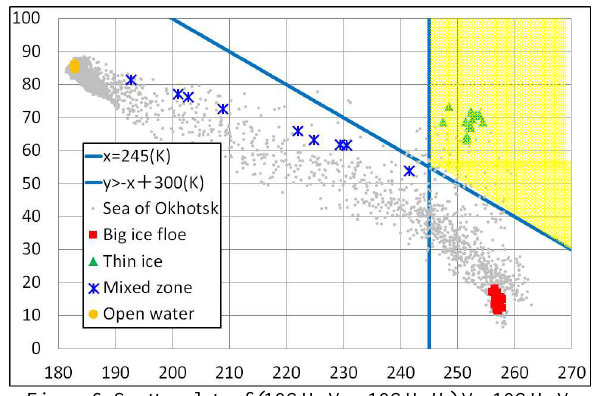
Figure 6. Scatter plots of (19GHzV – 19GHzH) Vs